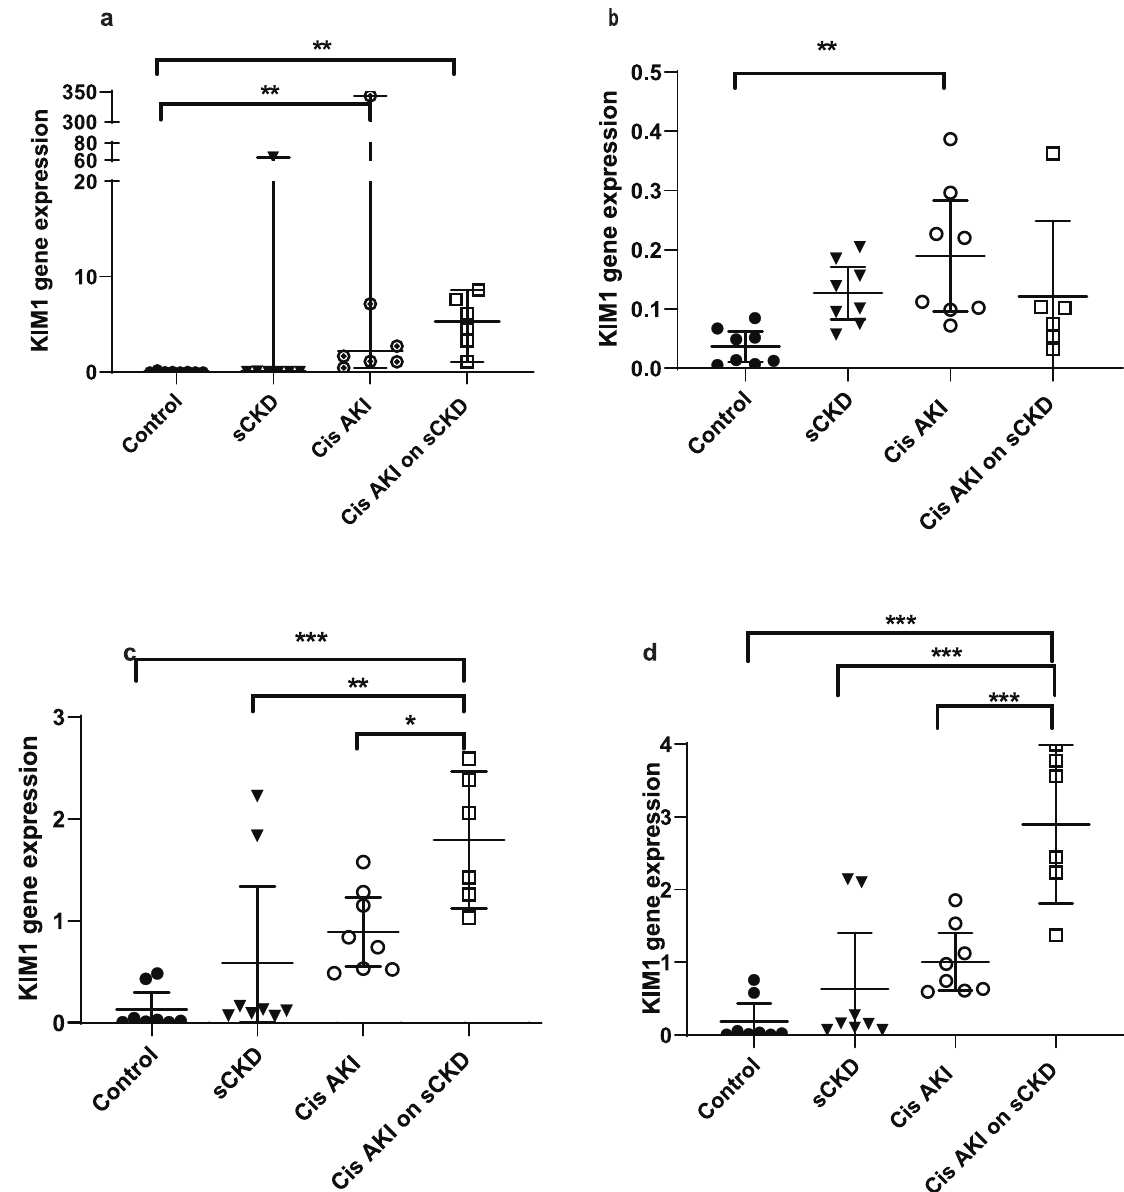
Fig 2. Expression of KIM-1 normalised to a) 18S , b) GAPDH , or c) PABPN1×HMBS or d) ACTB×PABPN1 following AKI induced by Cisplatin or IRI. Data are means (one-way ANOVA) or medians (Kruskal Wallis) and 95% CI (n � 6). � p < 0.05, �� p < 0.01, ��� p <